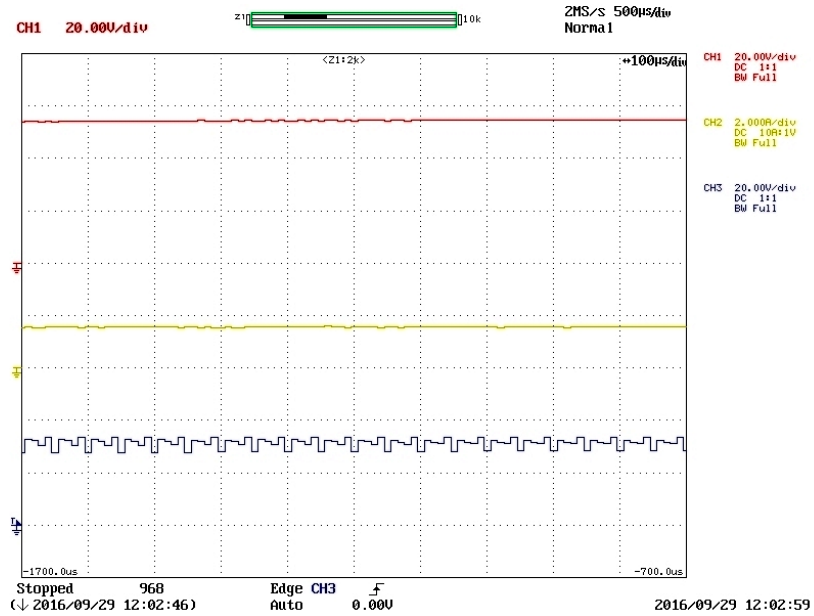
Figure 22. Results (for 10:00 A.M.) obtained by hardware implementation: CH1 : voltage across the load resistance (54.5 V); CH2 : current across the load (1.4 A); and CH3 : solar PV array’s terminal voltage ( V PV = 33 V).